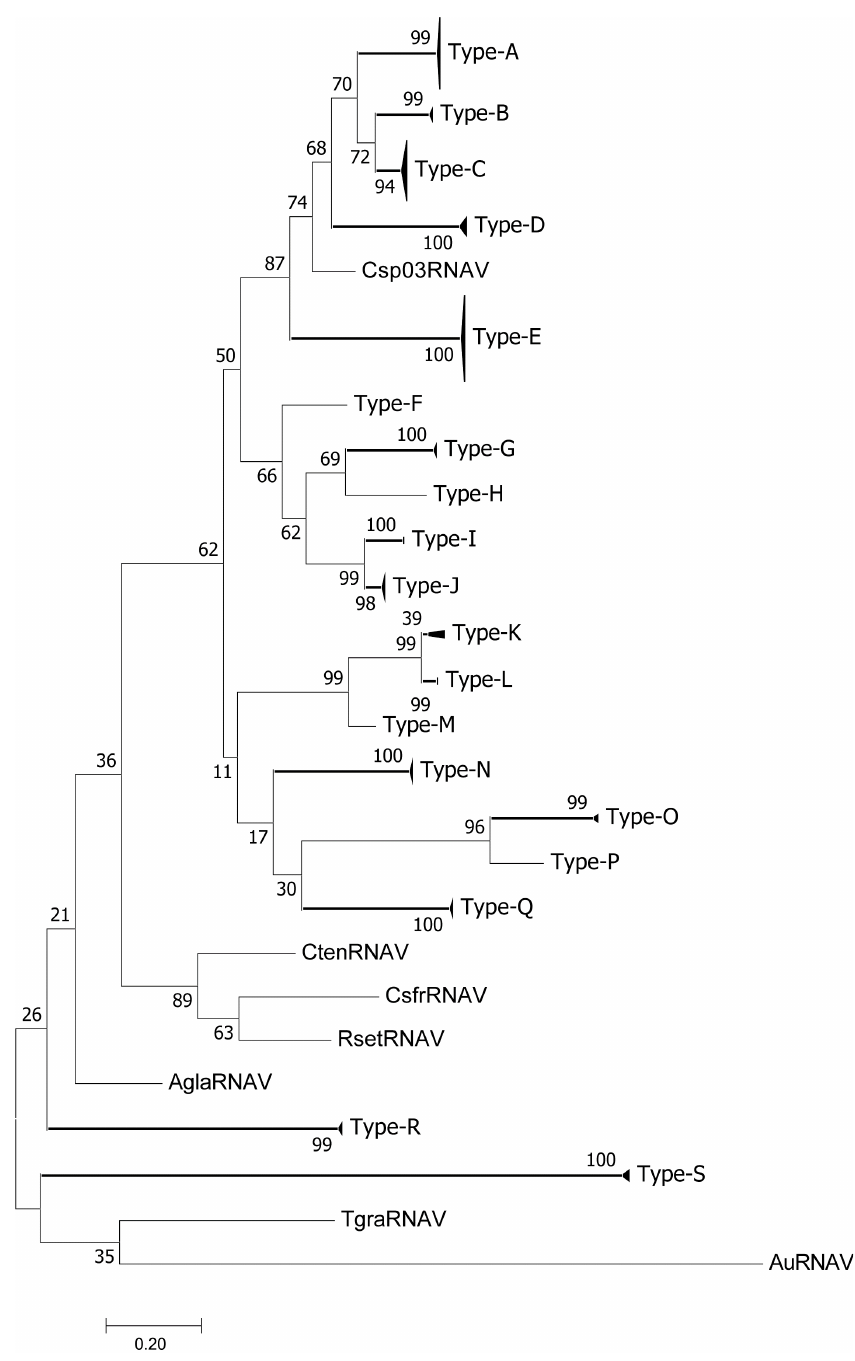
Figure 1. Phylogenetic analysis of ssRNA viruses. Maximum likelihood (ML) trees of ssRNA viruses on the basis of RNA-dependent RNA polymerase sequences. Bootstrap values (percent) from 1000 replicates are shown at the nodes. ML distance scale is shown under the ML